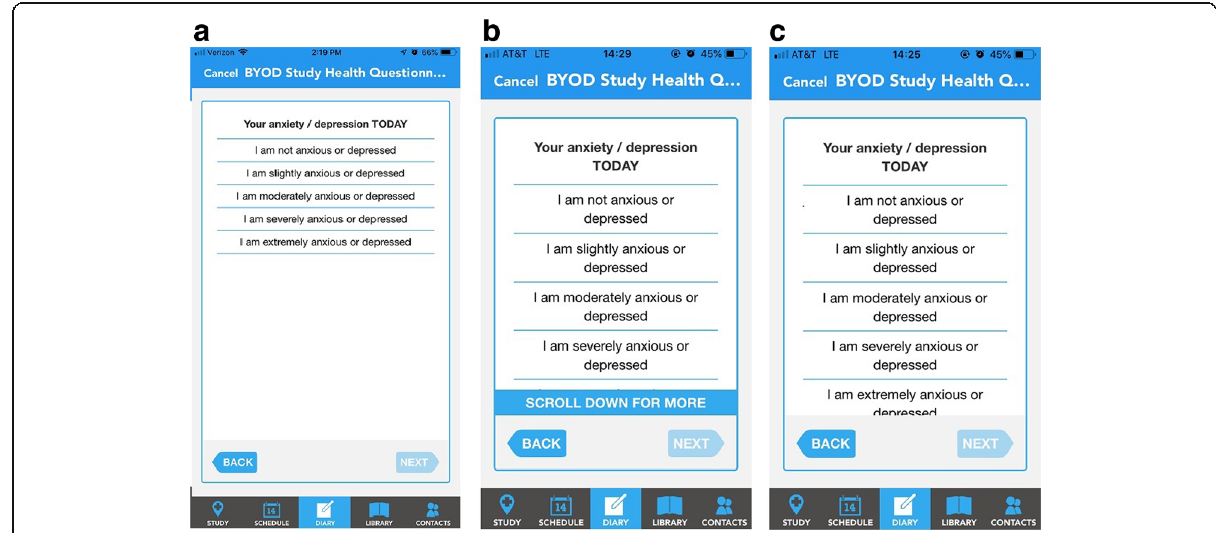
Fig. 1 Format and layout differences for ( a ) no scrolling, ( b ) scrolling with the smart-scrolling feature, and ( c ) scrolling without the smart-scrolling